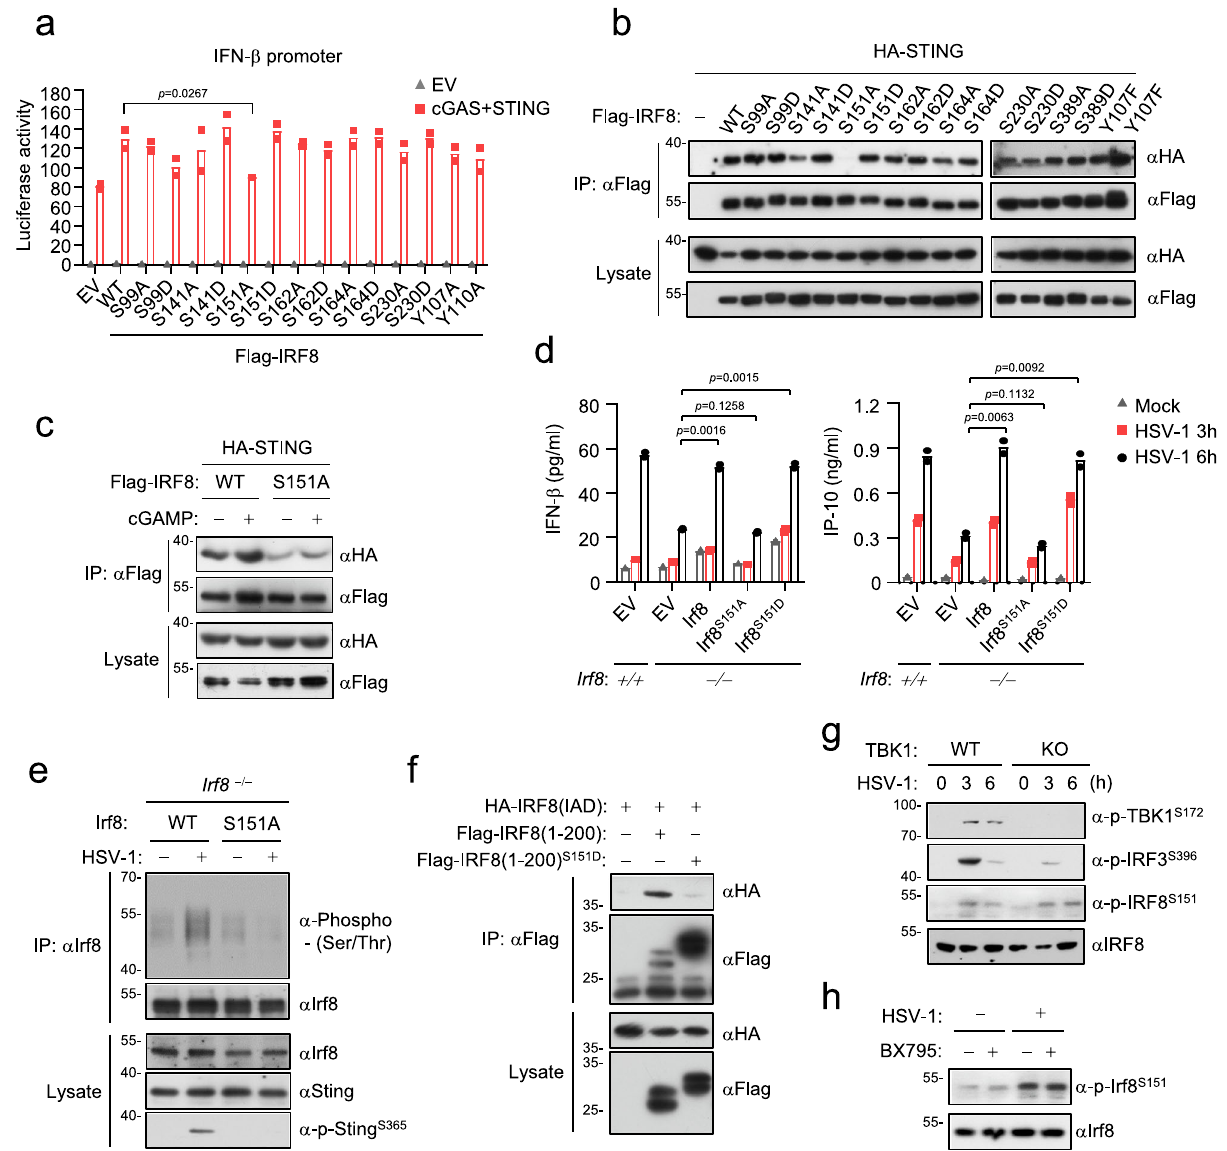
Fig. 5 | Phosphorylation of Irf8S151 is essential for Sting-mediated signaling. a Reporterassaysfor IFNB1 promoteractivityinHEK293Tcellstransfectedwiththe indicated plasmids for 24h. Data are presented as mean ± AD, n =2 technical repeats. Data were analyzed by unpaired two-tailed Student ’ s t-test. b Interactions of STING with IRF8 and its mutants. HEK293T cells were transfected with the indicated plasmids for 20h followed by co-immunoprecipitation and immuno- blotting analysis with the indicated antibodies. EV, empty vector. c Effects of cGAMP stimulation on association of Sting with Irf8 or Irf8 S151A . HEK293 cells were transfectedwiththeindicatedplasmidsfor24handthenuntreatedortreatedwith cGAMP for 4h. Co-immunoprecipitation and immunoblotting analysis were per- formedwiththeindicatedantibodies. d ELISAanalysisofIfn- β andIP-10secretionin WT and Irf8 − / − BMDMs reconstituted with the indicated plasmids. Cells were left uninfected or infected with HSV-1 for the indicated times. Data are presented as